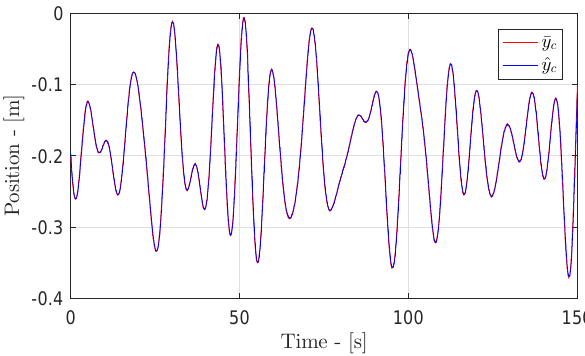
Figure 11: Positional comparison in the y-direction.